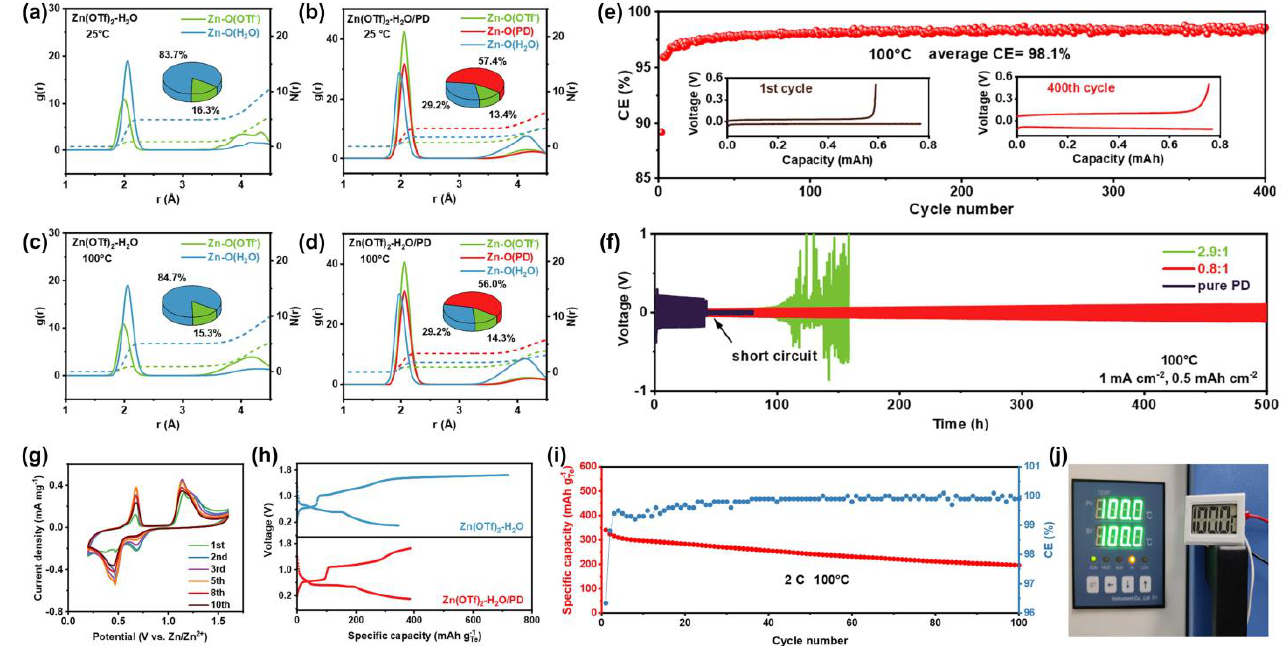
Figure 14. ( a – d ) RDFs of the agents coordinated to Zn 2+ in different electrolytes at 25 °C and 100 °C; ( e ) CE evaluation of the asymmetric Zn||Ti cell and ( f ) cycling test of the symmetric Zn||Zn cell at 100 °C; ( g ) CV curves of the AZTeBs at 100 °C; ( h ) GCD curves of the AZTeBs in different electrolytes at 100 °C; ( i ) cycling performance of the AZTeBs based on the Zn(OTf) 2 -H 2 O/PD electrolyte at 100 °C; ( j ) a photograph of a temperature sensor powered by the AZTeBs at 100 °C (reproduced with permission from Ref. [106]. Copyright 2022, American Chemical Society).